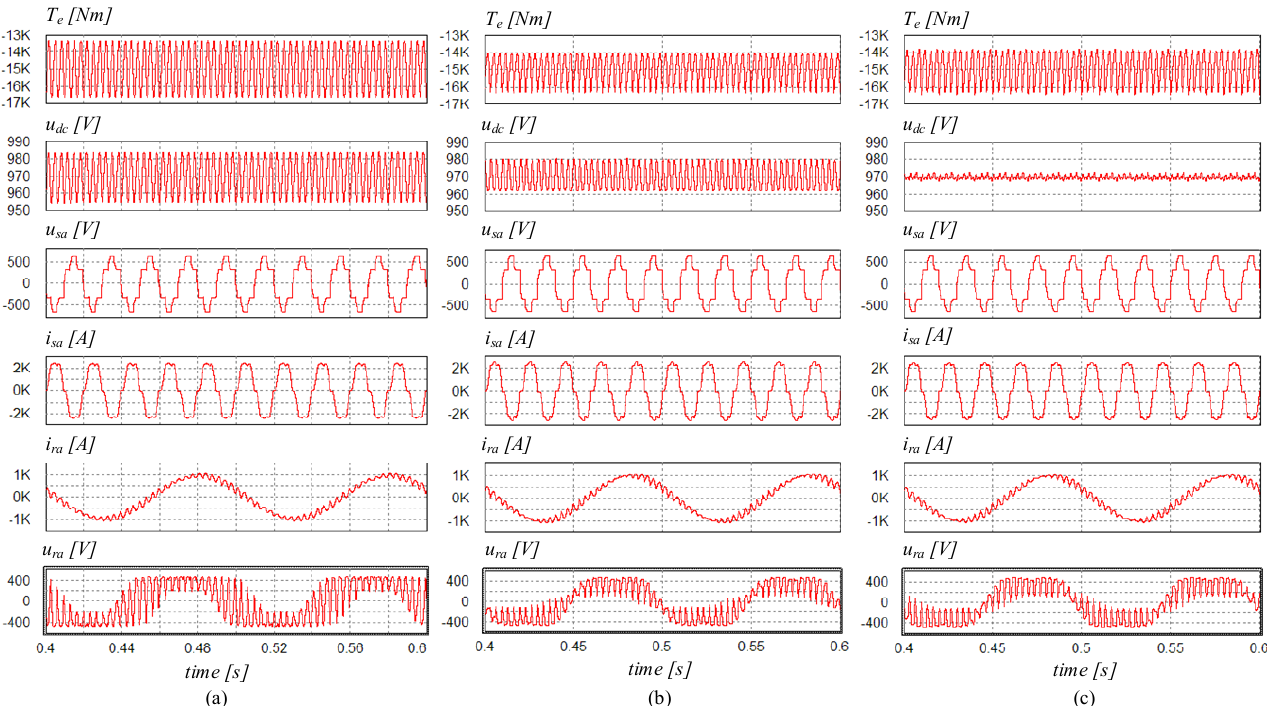
Figure 6. Simulation results of a 2 MW DFIG-DC system at 1200 rpm for field-oriented control FOC ( a ), direct torque and flux module control DT Ψ C ( b ), and the proposed direct torque and x variable control DTXC ( c ) with limited rotor voltage at the steady state.